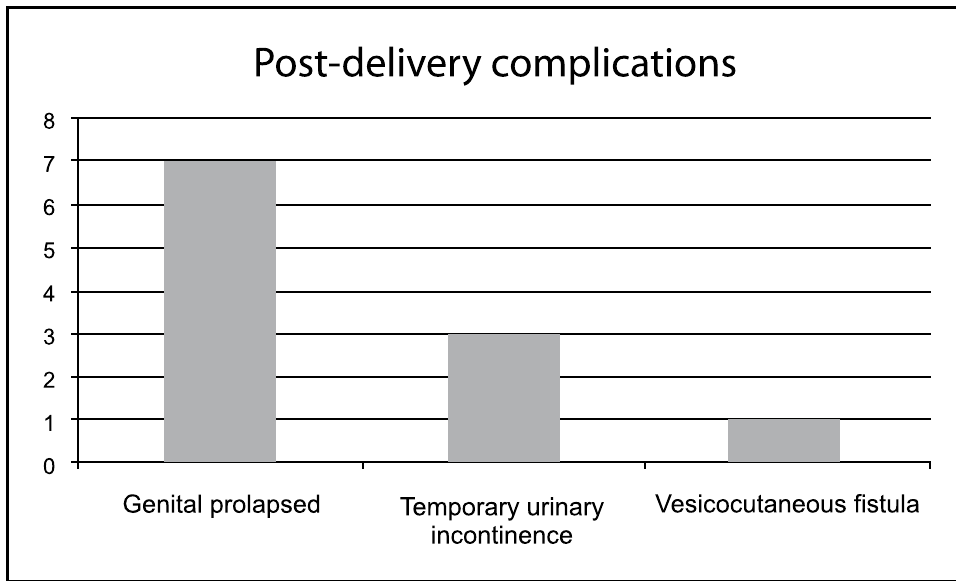
Figure 2 - Post-delivery complications of the 14 patients. One of the genital prolapsed patients had to underwent a